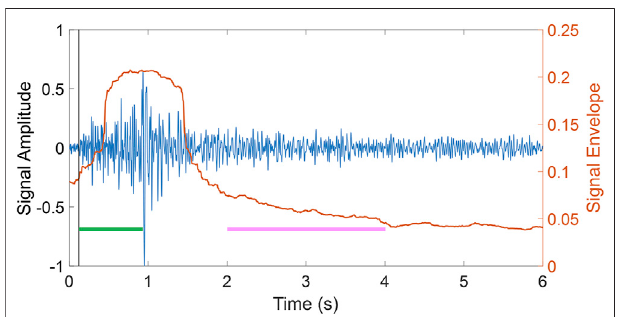
FIGURE 2 | Signal example. Seismogram (blue) and its envelope (orange). The vertical black thin line marks the P-wave arrival. The coda window section is represented by the pink line, while the green line shows the peak delay measured on this